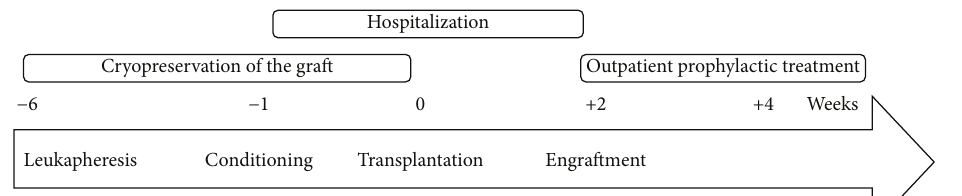
Figure 1: Outline of AHSCT. Key steps of AHSCT include the following. Leukapheresis: mobilization of hematopoietic stem cells following administration of cyclophosphamide and granulocyte-colony stimulating factor (G-CSF). The autologous graft that is harvested from the peripheral blood by leukapheresis is then cryopreserved. Conditioning: a cytotoxic high-dose conditioning regimen is administered during hospitalization for AHSCT. Transplantation: the autologous hematopoietic graft is then reinfused (transplantation), and supportive care is provided during hospitalization for neutropenia until engraftment. Engraftment: following engraftment, close outpatient monitoring and prophylactic treatment are